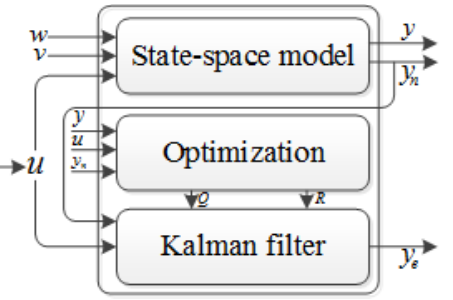
Figure 6. Parallel model for pushing distance tracking with varying optimization methods.